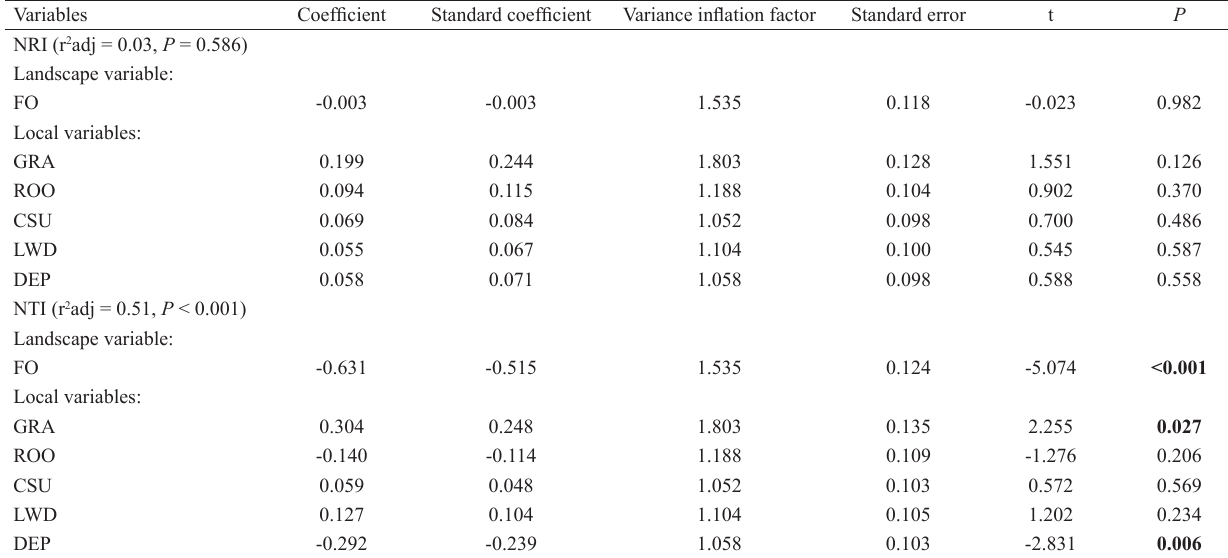
Fig. 2. Biplot resulting from the distance based Redundancy Analysis with seven variables (landscape and local). The proportion of forest cover in the watershed, the proportion of grasses in the stream banks, and depth significantly explained the NTI (nearest taxon index) in the studied communities and therefore are represented here. Each community is identified by circles with different sizes according to the NTI values. Table 3 . Results from the partial regression analysis, including NRI and NTI as dependent variables. For variables codes, see Table 1. Bold numbers of P indicate variables that significantly explain the functional